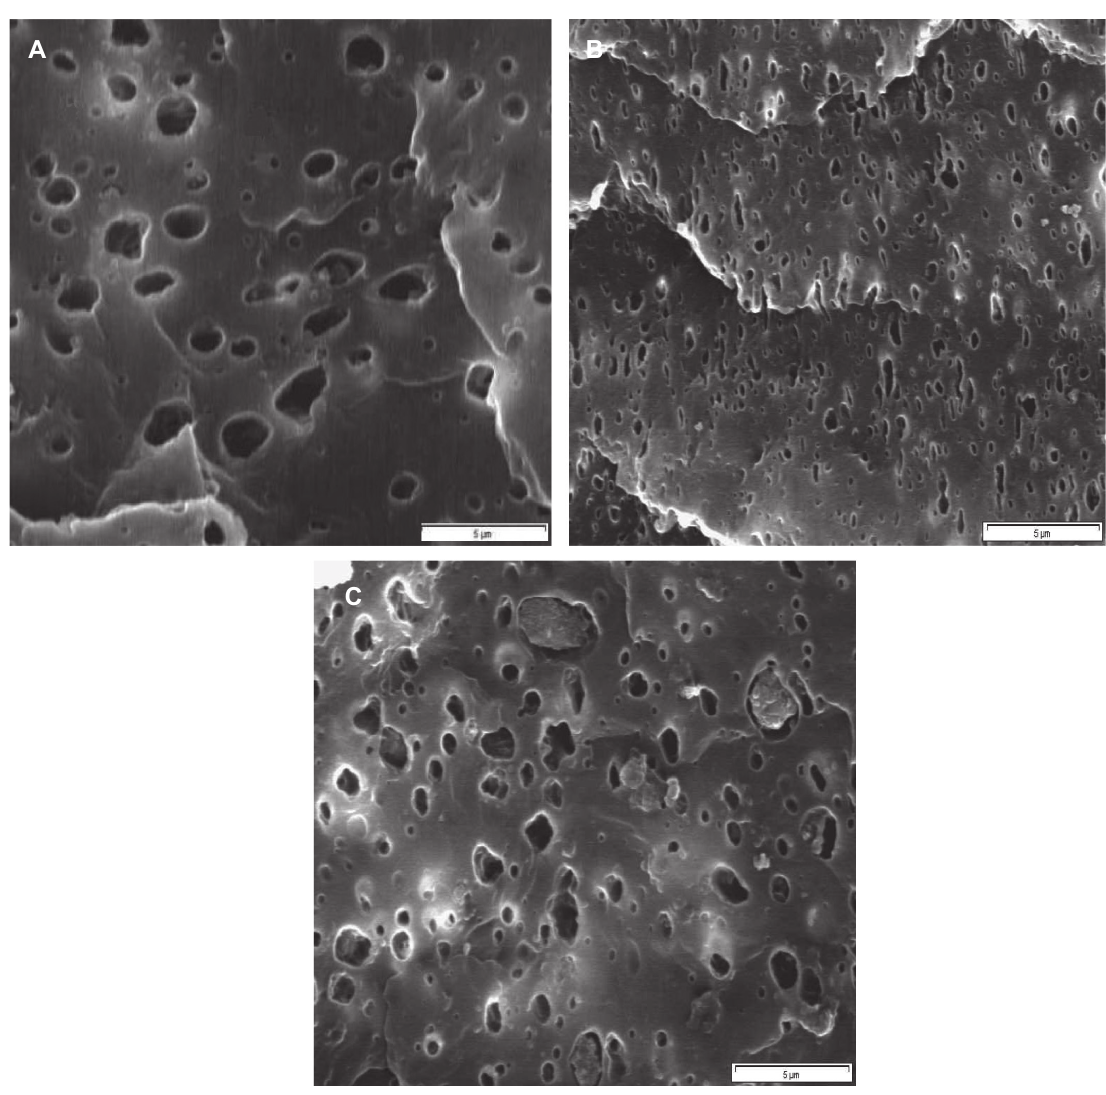
Figure 1 SEM micrographs of PP/EPDM/SWNT nanocomposites: (A) 0, (B) 0.5, (C) 5 wt.% of